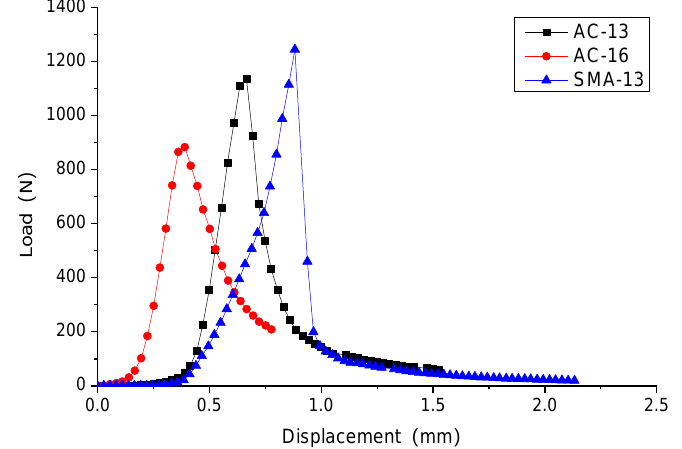
Figure 5. Load-displacement diagram of asphalt mixture beams with a notch depth of 4 mm.